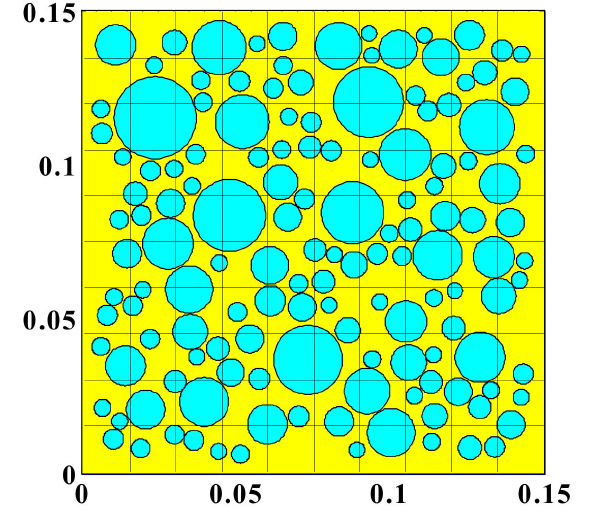
Figure 12. Random aggregate model of concrete (unit: